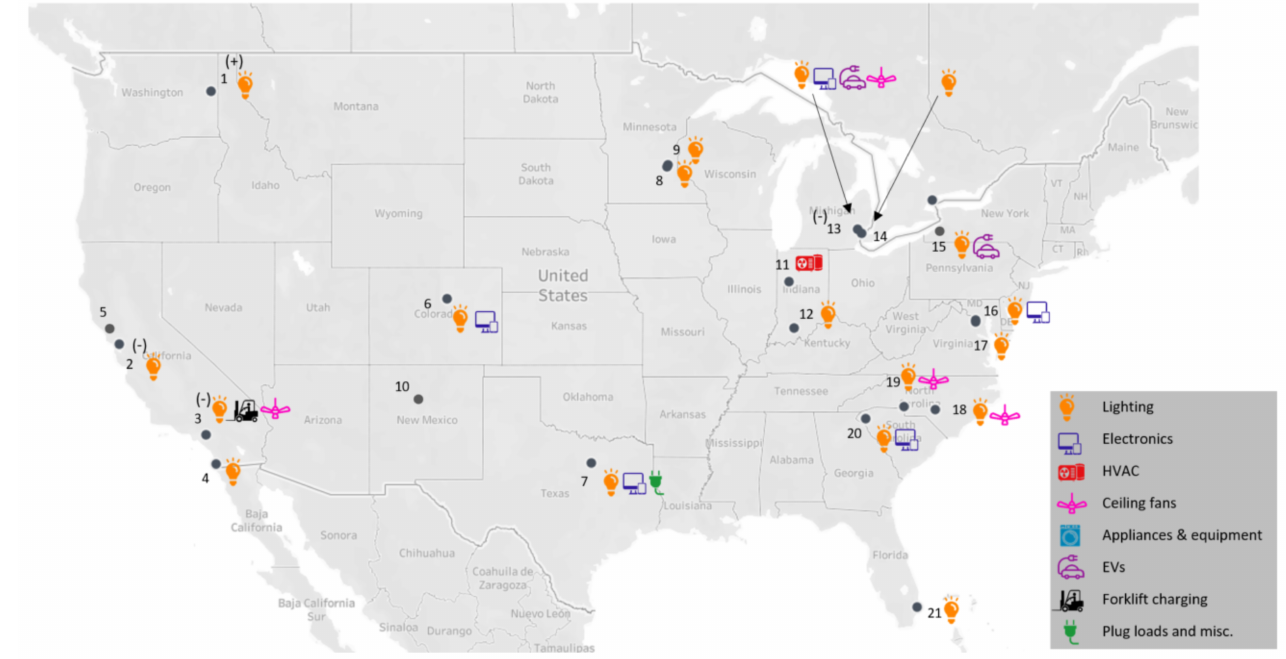
Table 2. Information on DC field deployments in the United States and Canada